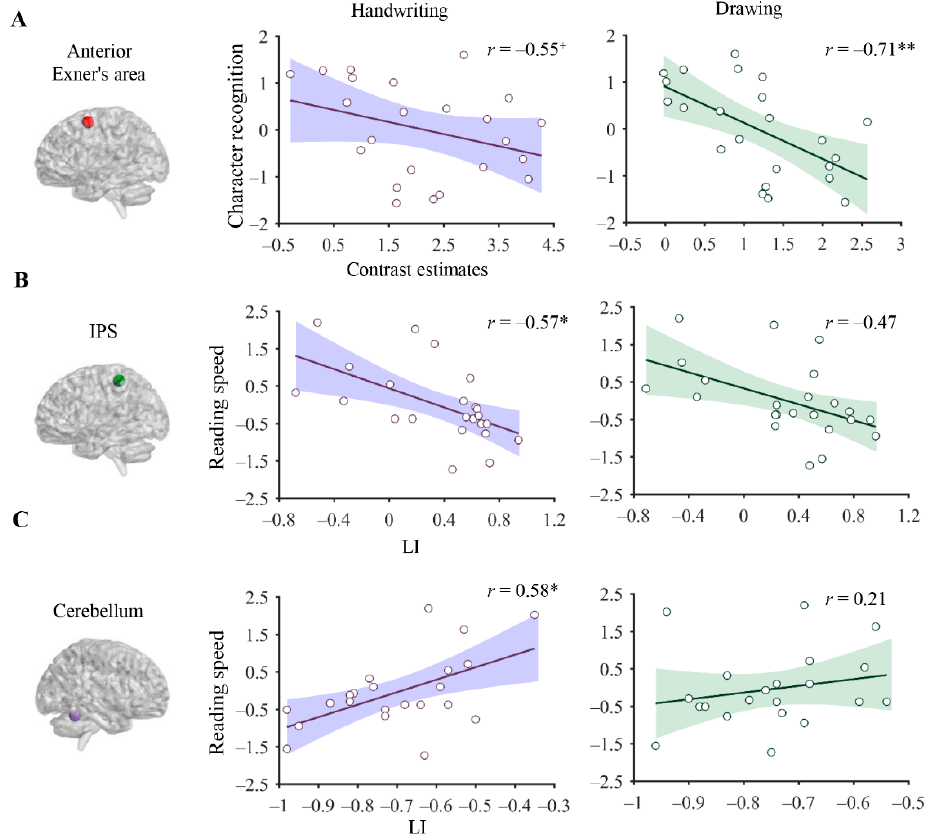
Figure 4. Scatter plots displaying the correlations of brain activity associated with handwrit- ing/drawing and reading skills. Correlations of activation in the anterior Exner’s area during hand- writing/drawing versus rest with character recognition scores ( A ). The correlations of the functional lateralization of the IPS ( B ) and cerebellum ( C ) with reading speed. IPS = inferior parietal sulcus, + FDR corrected p < 0.1, * FDR corrected p < 0.05, ** FDR corrected p < 0.01.